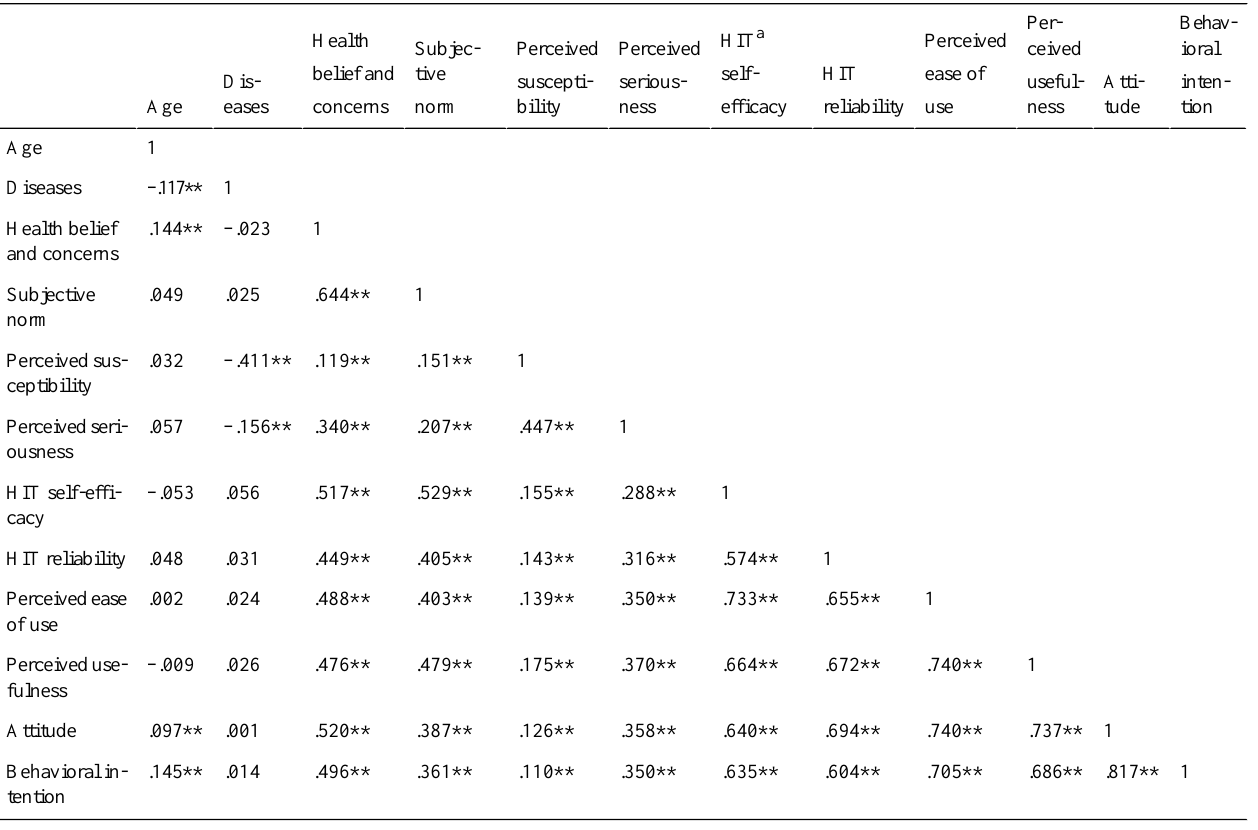
Table 4. Correlation coefficients between measured